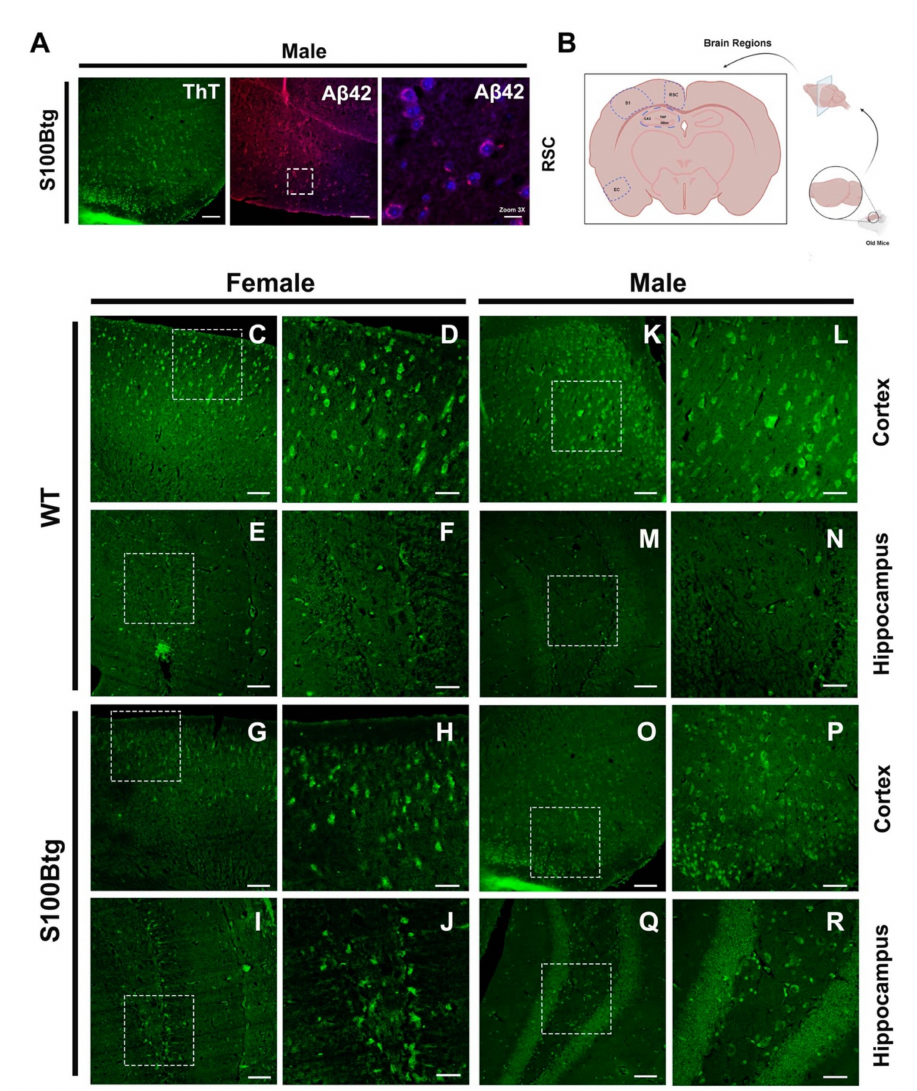
Figure 6. Brain amyloid- β deposition in S100Btg mice. In ( A ), pattern of labeling comparing ThT and amyloid- β immunofluorescence. ( B ), brain regions, the dorsal hippocampus and cortex, of S100B transgenic and wild-type mice investigated by Thio-flavin T (ThT) affinity. In ( C – R ), Tht fluorescent images of male and female brains of wt and S100Btg mice, magnified by 10 × and 40 × , respectively. Scale bars = 150 µ m (left panels) and 50 µ m (right